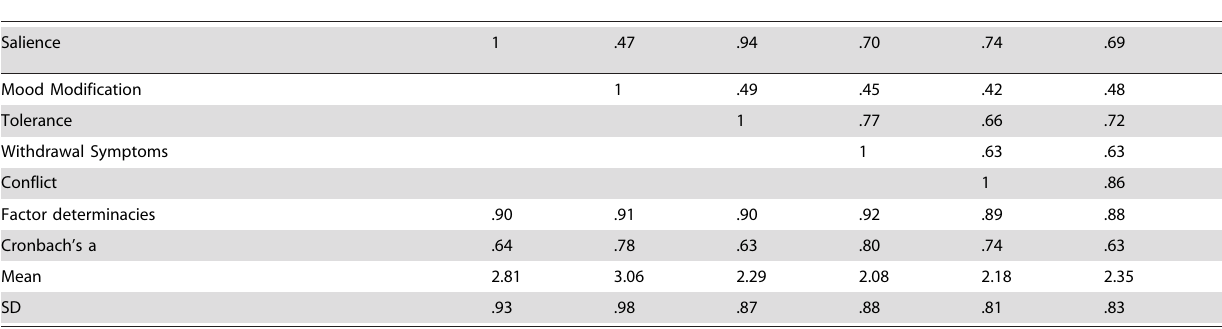
Table 4. Summary of the Confirmatory Factor Analysis Results on the IGD-20 Test Items.